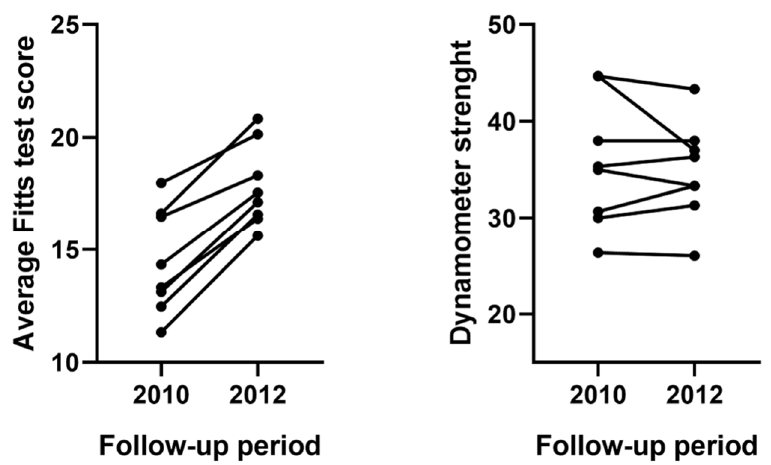
Figure 6. Change in psychomotor (FTT) and physical hand (dynamometer) performance over 2-year follow-up in eight pwMS. Legend: FTT—Fitts’ Tapping Task, pwMS—people with multiple sclerosis. Paired t -test was used to calculate the intraindividual change in Fitts’ Tapping Task and dynamometer measures. Each line represents one pwMS that was followed over 2 ‐ years.